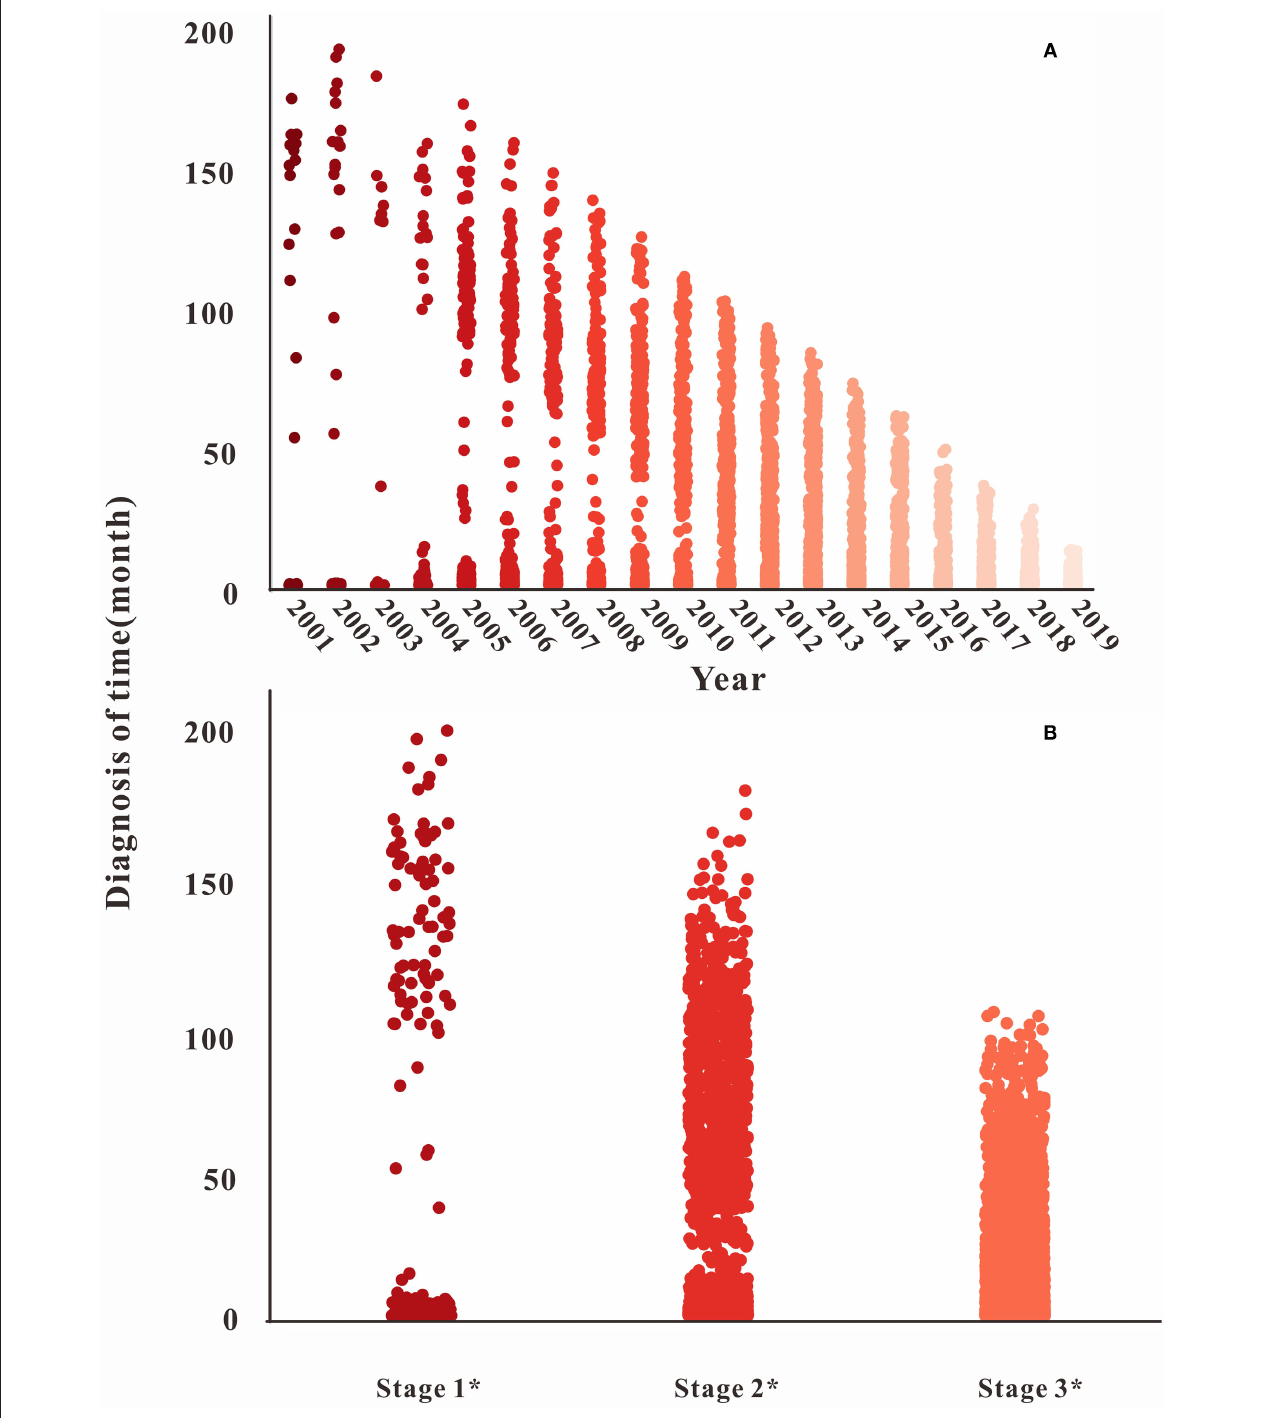
FIGURE 6 | Time of diagnosis in different years and stages. (A) The diagnosis time changes from 2001 to 2020; (B) the diagnosis time changes in different stages.